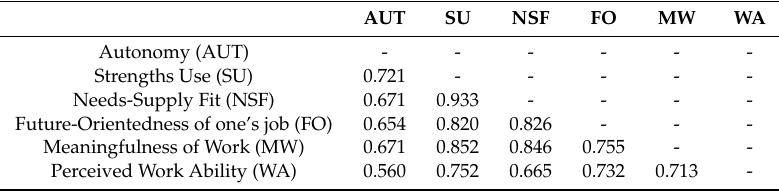
All correlations are significant at p <